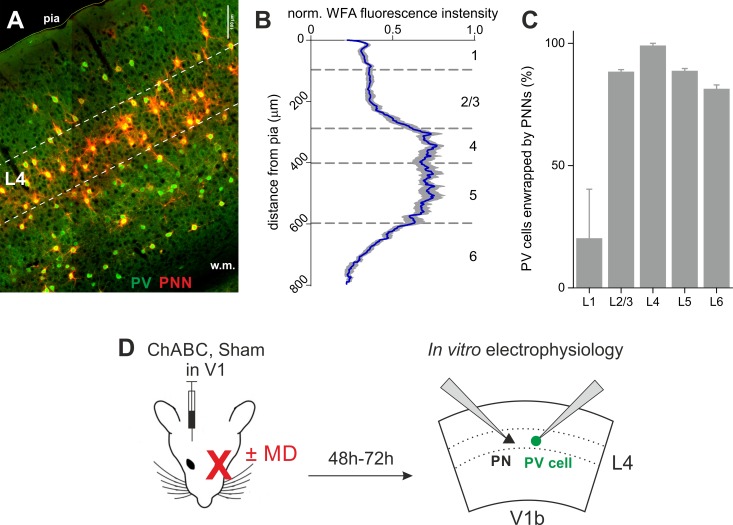
PNNs surrounding PV cells are abundant in L4 of V1.(A) Epifluorescence image of primary visual cortex (coronal slice, 200 µm) from an adult mouse. PNNs are in red (WFA staining) and PV cells in green (parvalbumin staining). Dotted lines delimitate layer 4. (B) Normalized WFA fluorescence intensity (X axis) across cortical layers (Y axis). Blue line: mean; grey area: standard deviation (n = 10 slices from seven mice). (C) Summary plot illustrating the percentage of PV cells enwrapped by PNNs across cortical layers. (D) Experimental protocol: mice were injected in V1 in vivo with ChABC (or PBS, in sham-treated animals). After 2–3 days, we obtained acute cortical slices and recorded PV cells or PNs in layer 4 of the binocular portion of V1 (V1b). Some mice underwent monocular deprivation. PV = parvalbumin positive interneuron. PN = principal neuron. MD = monocular deprivation.
10.7554/eLife.41520.007Figure 2—figure supplement 1—source data 1.Source data for Figure 2—figure supplement 1B.